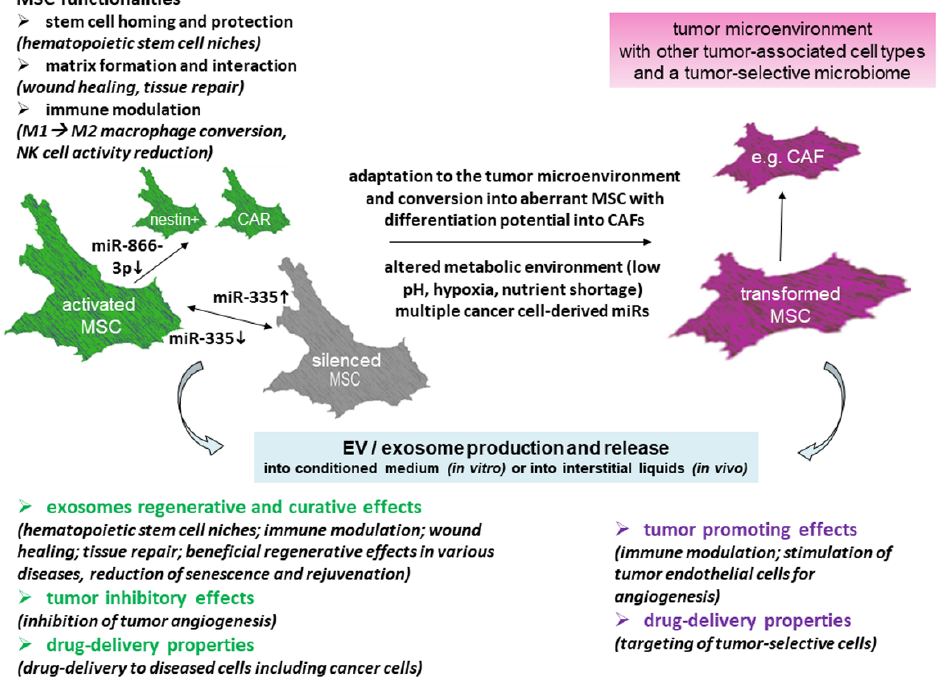
Figure 2. MSCs display several functionalities within the body. These are conferred predominantly after MSC-mediated release of exosomes following activation, e.g., by altered expression levels of miR-335 [68]. MSC-derived exosomes represent a heterogeneous population of vesicles that are equipped with different biological contents, including a large variety of miRs. Thereby, exosomes from normal MSCs can display regenerative, curative, and tumor-inhibiting effects. Following close interactions with cancer cells, however, MSCs can progressively develop along an aberrant tumor-associated phenotype. Accordingly, these tumor-associated MSCs release exosomes with altered cargo, eventually exhibiting tumor-supporting properties. Thus, MSCs can release exosomes with divergent functionalities depending on the microenvironment and the influence of local cellular interactions (scheme adapted from [48]).